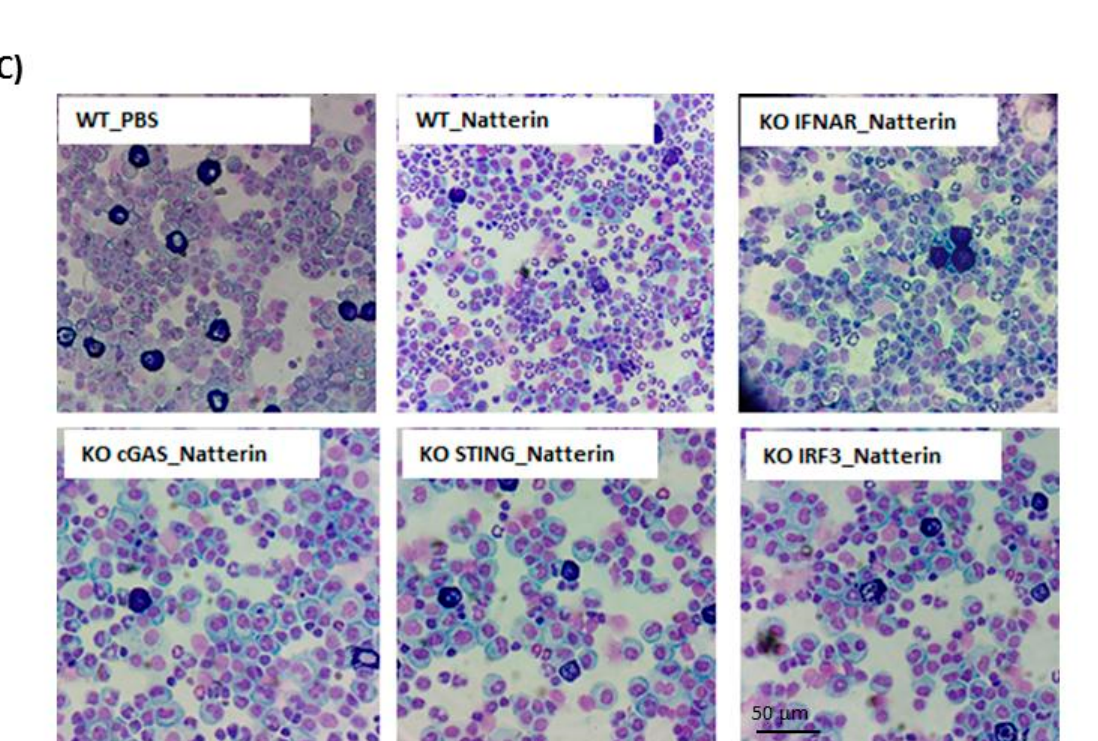
Figure 3. cGAS/STING via type I IFN axis supports the neutrophilic inflammation. Natterin (1 μ g) diluted in PBS was i.p. injected into BL6 WT ( WT _Natterin) or in ifnar -, il-28r -, or ifn γ r -deficient mice ( A ), or in cgas -, sting - or irf3 -deficient mice ( KO _Natterin groups) ( B ). Two hours after Natterin injection, mice were killed and the peritoneal cavities were washed to obtain exudates. Peritoneal exudate cells were harvested and the number of neutrophils related to total cell number was evaluated in cytospin slides stained with the Diff-Quick staining kit. Examples of representative